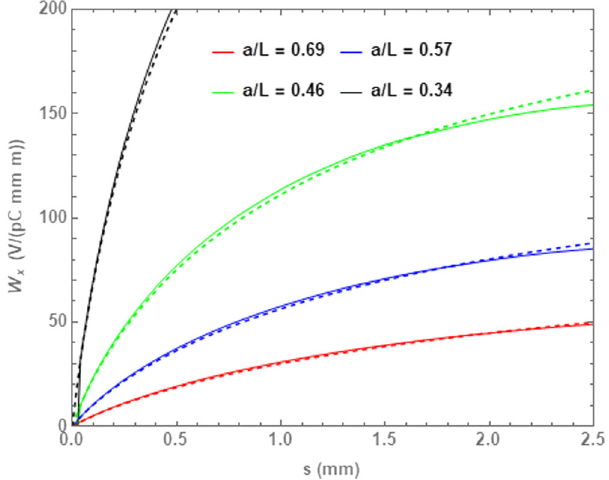
FIG. 33. The short-range wakes calculated via the CFD code (solid) and the fitted wakes (dashed) found by Eq. (45). The two methods of yielding the wakes agree well over the considered range of a=L .